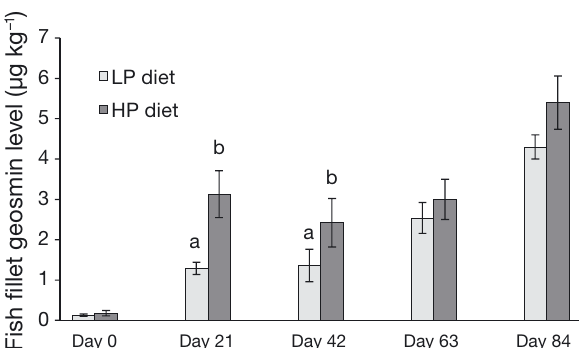
Fig. 2. Oncorhynchus mykiss . Concentration of geosmin in rainbow trout flesh fed low-phosphorus (LP) and high- phosphorus (HP) diet for 84 d. Data are means (±SD) of 4 tanks (3 fish per tank) per diet. Different letters above bars indicate significant difference at p < 0.05